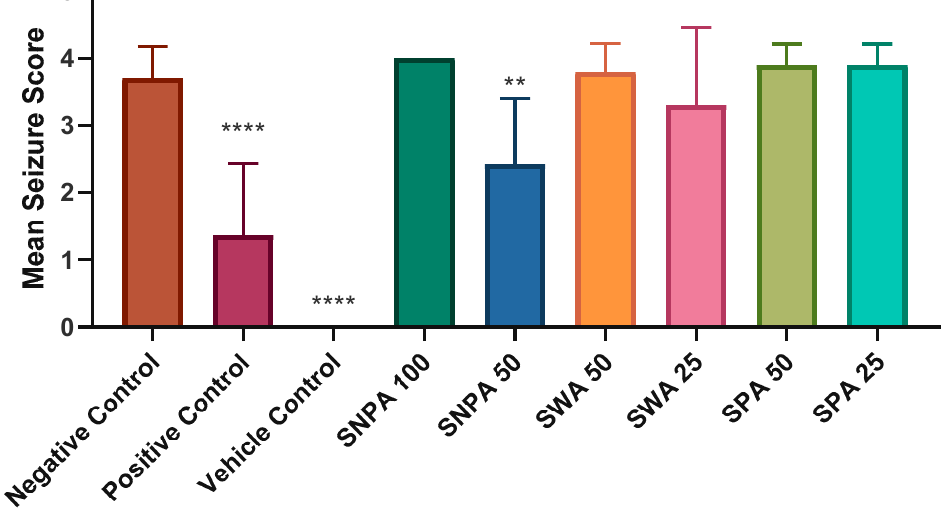
Figure 3. Graphical representation of mean seizure score in various groups of PTZ model. The data was compared to the negative control group using one-way ANOVA (**** p < 0.0001; ** p < 0.01). The figure represents mean ± SEM of the highest seizure score in each group ( n = 10).